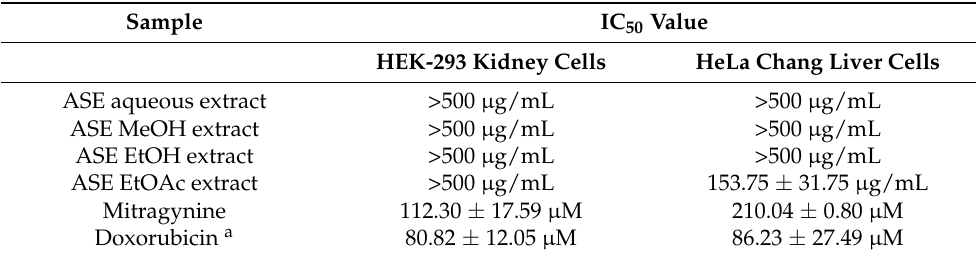
Table 5. IC 50 values following treatment with mitragynine, doxorubicin, M. speciosa ASE leaf extracts in HEK-293 kidney cells and HeLa Chang liver cells.